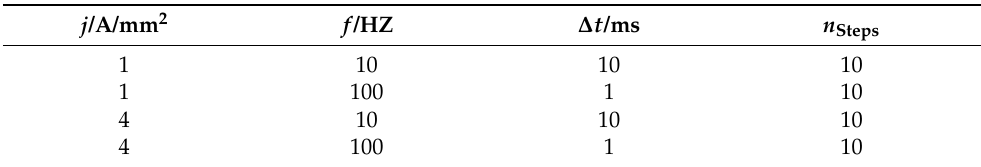
Table 1. Four simulation setups to find the basis and to train the ECSW element selection at a constant temperature of T = 20°C.